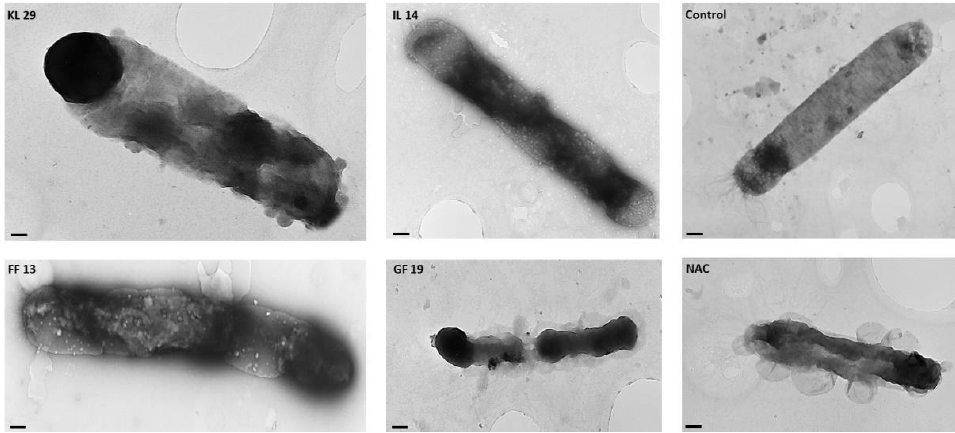
Figure 5. Transmission electron micrographs of AMP-treated Xf cells (IL14, GF19, KL29, FF13), showing structural, cell wall, and cytoplasm alterations. Control: untreated Xf cells. NAC—N-acetyl-L-cysteine-treated Xf cells. Bar: 100 nm.